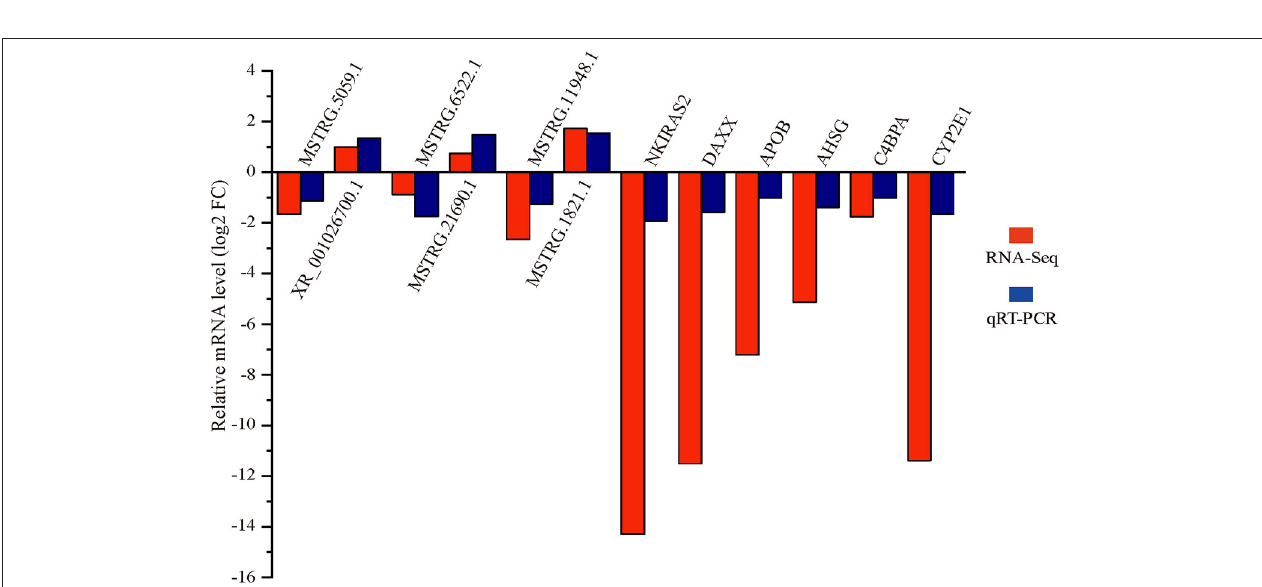
FIGURE 4 | GO and KEGG enrichment analyses of differentially expressed lncRNAs and mRNAs. (A) Annotated GO terms of target genes of differentially expressed lncRNAs. (B) Enriched KEGG pathways of target genes of differentially expressed lncRNAs. (C) Annotated GO terms of differentially expressed mRNAs. (D) Enriched KEGG pathways of differentially expressed mRNAs.